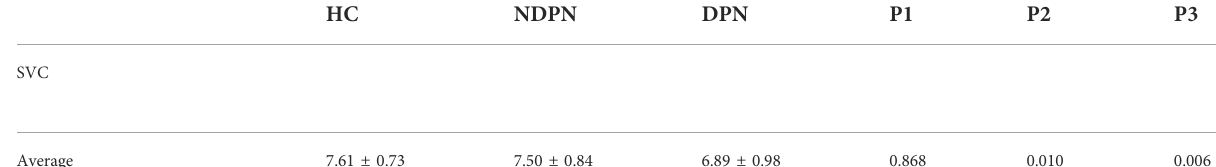
TABLE 2 Comparison of VLD value among the three